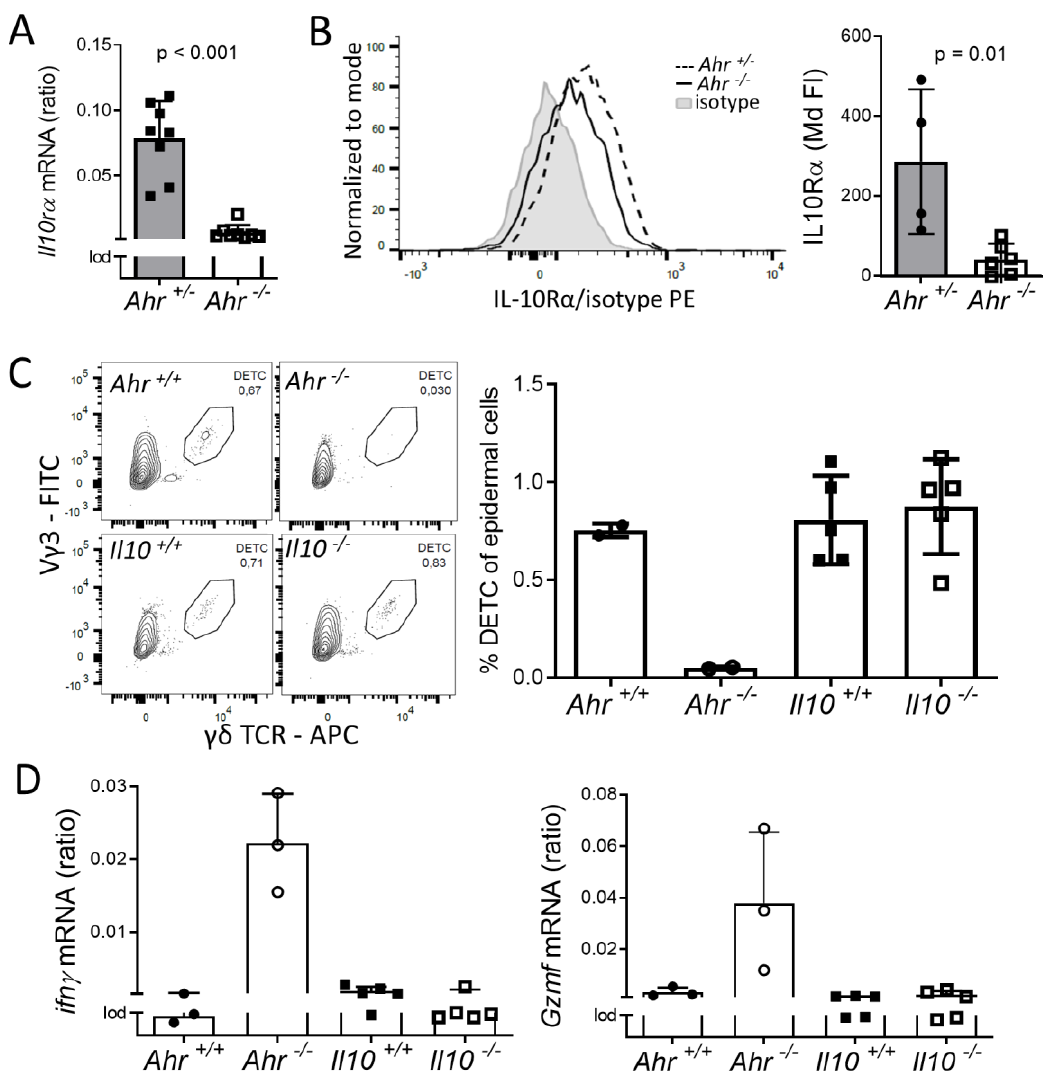
Figure 4. The influence of IL-10 signaling on DETC maintenance. ( A ) RNA of DETC, FACS-sorted from 2 weeks old mice, was isolated. Expression of Il10ra was measured by qPCR; shown are ratios referred to the housekeeper gene Rps6 ( n = 8 mice; Mann–Whitney-test). ( B ) isolated epidermal cells from 4–10 weeks old Ahr +/ - or Ahr - / - mice were stained with antibodies against γδ TCR and IL10R α or and isotype-antibody and analyzed by flow cytometry. Median fluorescent intensities (MdFI) of isotype-controls were subtracted from the MdFI of IL10R α and normalized to Ahr +/ - DETC (3 experiments, n = 4–6 mice, Mann–Whitney-test) ( C ) overnight cultivated epidermal cells from 6–8 weeks old mice were stained with antibodies against γδ TCR and V γ 3 and analyzed by flow cytometry (50000 events are displayed; n = 2–5 mice) ( D ) RNA was isolated from DETC FACS-sorted from 9–20 weeks old Il-10 +/+ or Il-10 - / - mice; expression of interferon- γ ( Ifn γ ) and granzyme-F ( Gzmf ) was measured by qPCR; shown are ratios referred to the housekeeper gene Rps6 ( n = 3–6 mice).